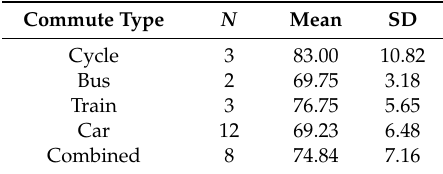
Table 4. Descriptive statistics for WHOQOL scores by commute type.